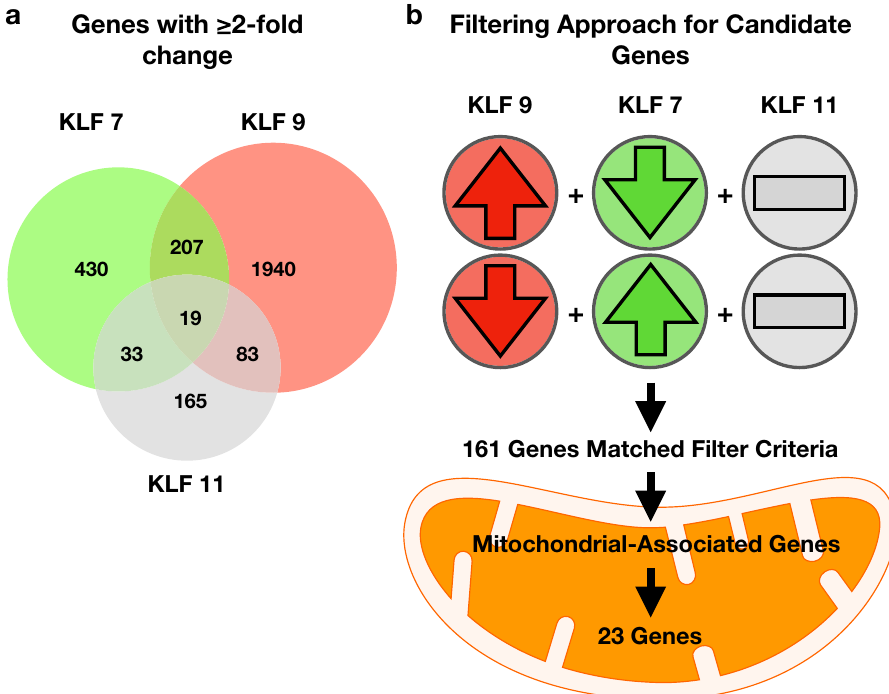
Figure 1. Microarray data collected from KLF expression experiments in RGCs. ( a ) KLF regulated genes expressed greater than or equal to 2–fold in a positive or negative direction. Data collected from lentivirus mediated KLF7, -9 or -11 expression in cultured RGCs. ( b ) Filtering scheme to identify axon growth regulating genes from a list of 2 fold changing genes. Genes were grouped based on opposing outcomes of KLF expression on RGC axon growth enhancement/suppression. Arrows represent a directions fold change and bars represent no fold change. Up/down regulations were considered when changes were > 2 fold with both KLFs, or slightly relaxed criteria of 2 fold change with one KLF and > 1.5 with the other KLF. In all scenarios the KLF11 regulation of a particular gene had to be < 1.5. A total of 163 genes met these criteria, of which 23 were considered mitochondrial associated based on gene ontology analysis. All fold changes were identified relative to lentivirus mCherry controls, and data were generated from N = 5 or more repeat RGC isolation, virus treatments, and microarray chips. Data analyzed with GenSpring 12.5–GX software, significantly expressed genes identified by a Oneway ANOVA and Welch test, p (Corr) cut-off of 0.05. See Supplementary Dataset 1, for raw, filtered, and candidate gene